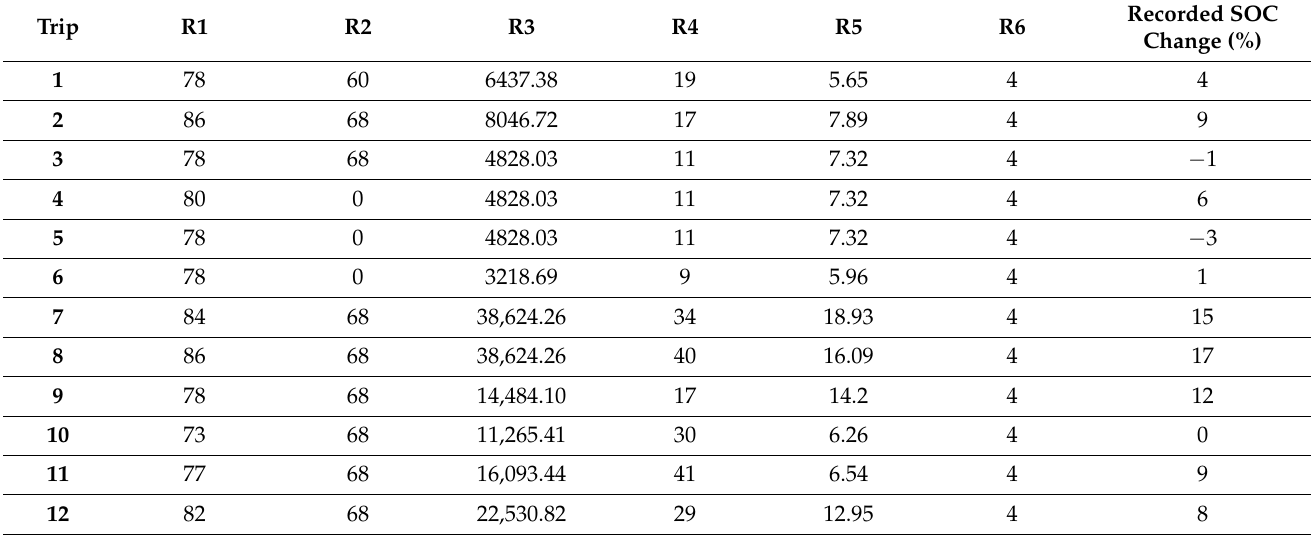
Table 5. Recorded data of 12 driving